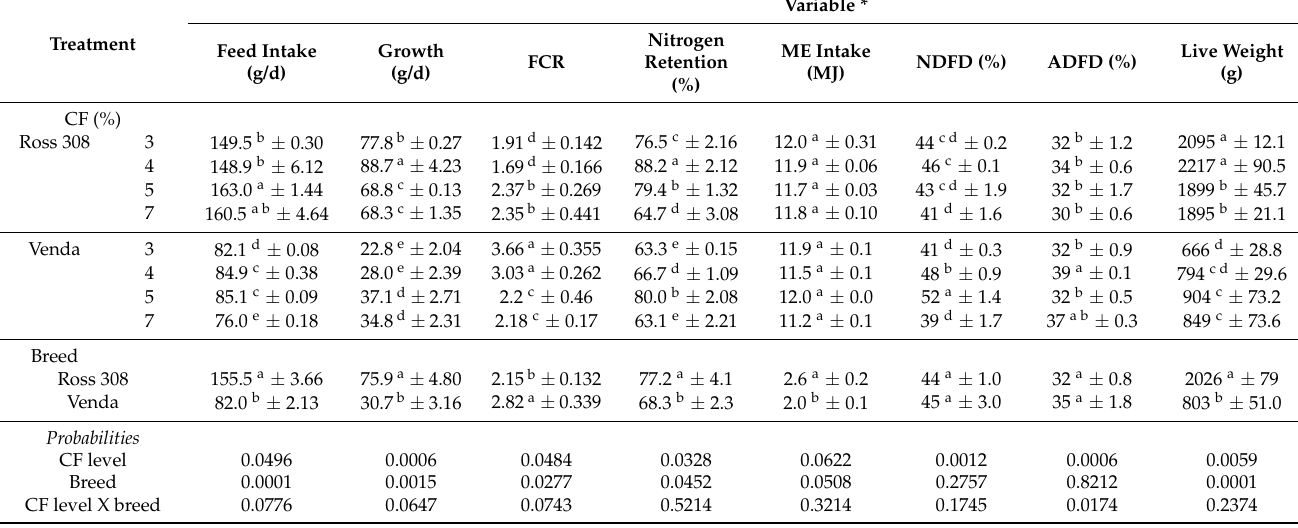
Table 6. The effect of the dietary crude fiber level on the production performance of the male Ross 308 broiler and Venda chickens aged 22 to 42